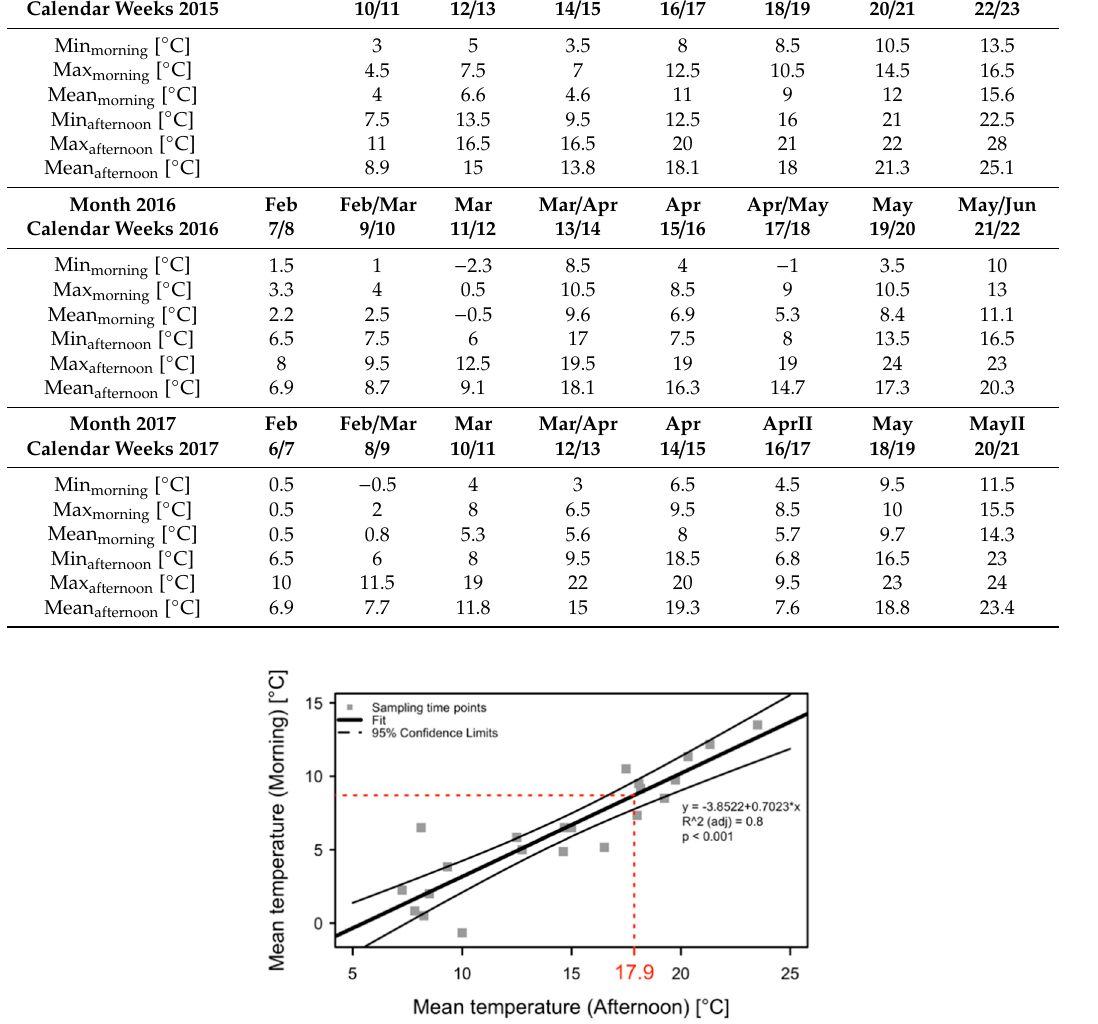
Figure A1. Correlation between mean temperature in the morning (7–9 am) and mean temperature in the afternoon (2–4 pm) in the studied apple orchard in 2015–2017.